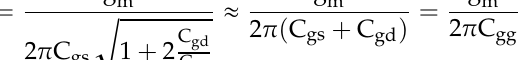
Figure 10. ( a ) Capacitance of HJLTFET versus Vgs; ( b ) capacitance of DMGE-HJLTFET versus Vgs. The cut-off frequency ( f T ) and gain bandwidth (GBW) are important indicators for evaluating RF performance of devices. Based on Figure 10a,b, the cut-off frequency ( f T ) and the gain bandwidth (GBW) of the HJLTFET and DMGE- HJLTFET are discussed in next section. As shown in Equation (3), cut-off frequency ( f T ) can be expressed as ratio of gm to C gg :